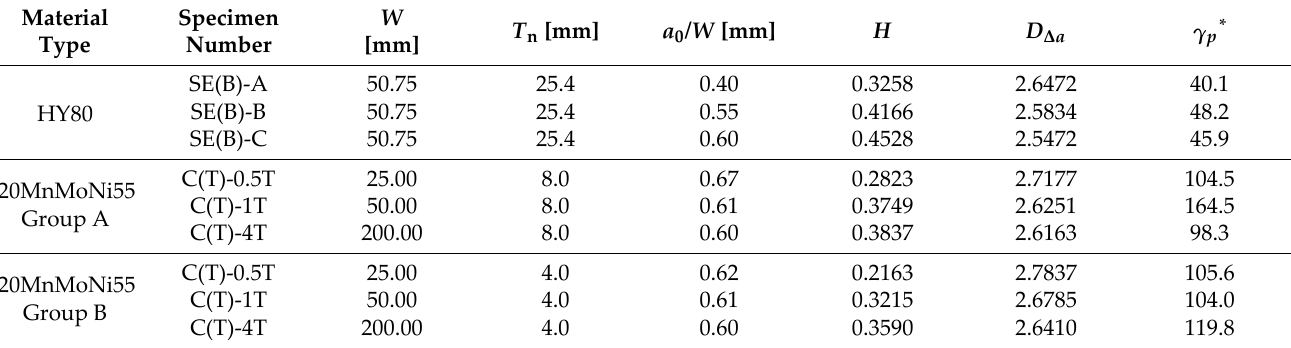
Table 1. Specimen geometries and fitted